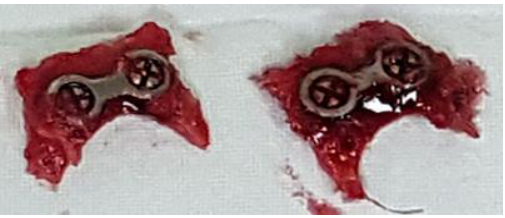
Figure 2. Samples extracted four weeks after the operations.